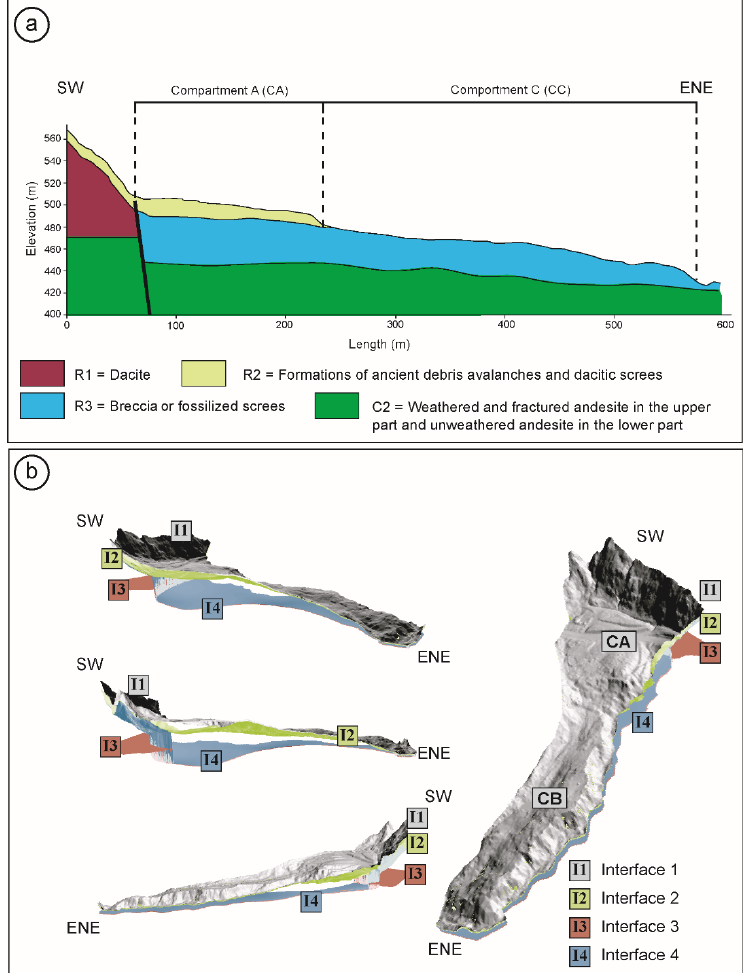
Figure 8. Geological model for the La Médaille landslide. ( a ) A 2D cross-section representing the different materials selected for physical-based modeling; ( b ) interfaces introduced for ALICE ® (hillshade map is produced with Helimap DTM, 2013).